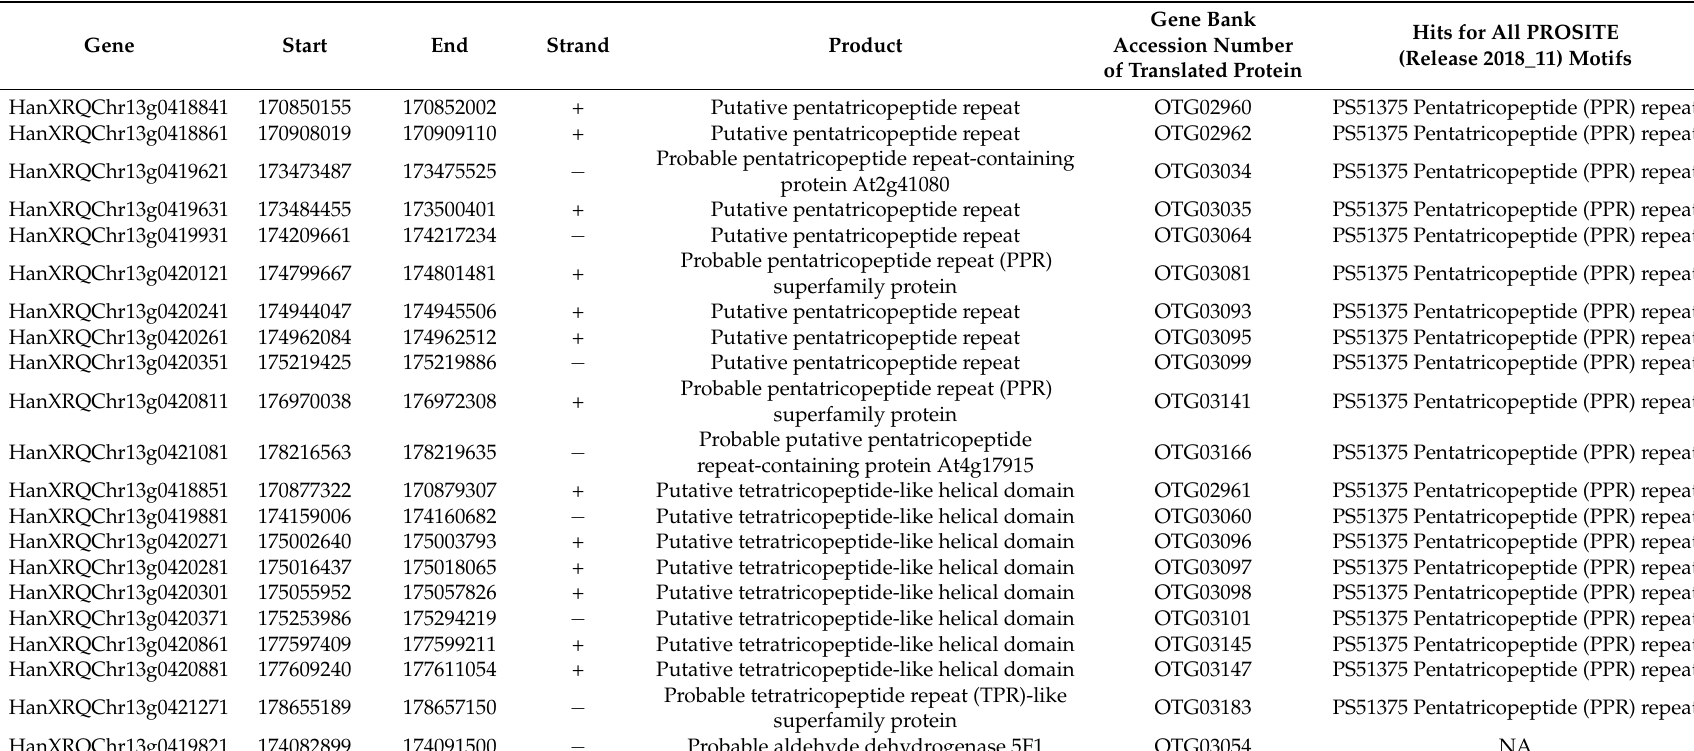
Table 2. The list of candidate Rf1 genes identified within the 7.72 Mb